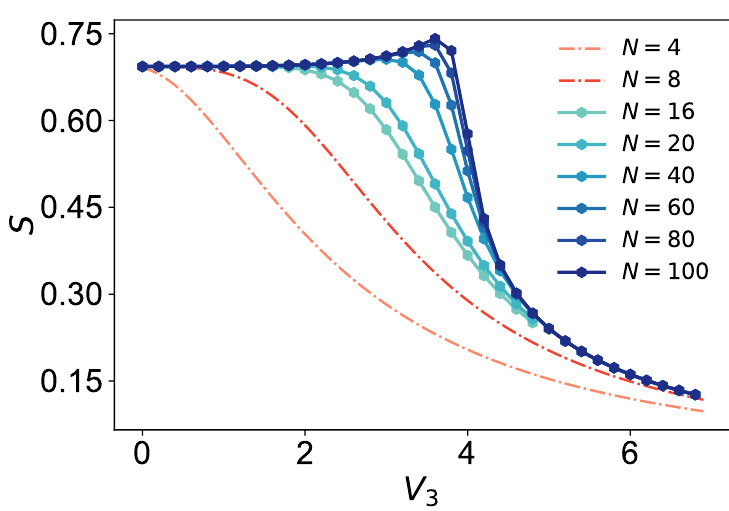
Figure 8: Entanglement entropy S as a function of NNNN repulsion V